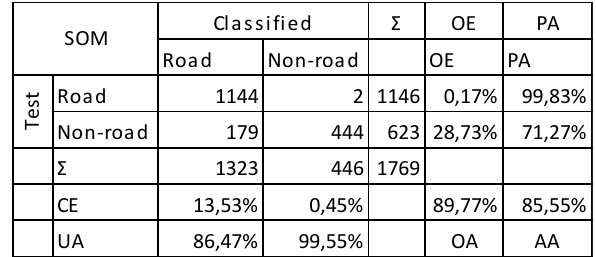
Table 2. In-sample accuracy for SOM classifier